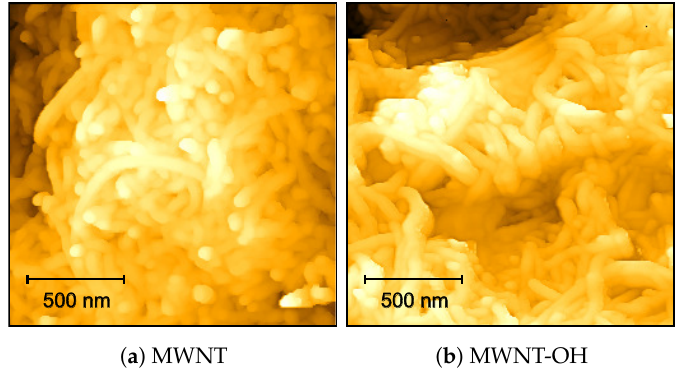
Figure 2. Atomic force microscopy (AFM) images of ( a ) MWNT and ( b ) MWNT-OH at a concentration of 2 mg/mL with scanned dimension of 1.7 µ m × 1.7 µ m. Table 1. The manufacturer-stated and AFM-calculated width of basic and functionalised multi-walled carbon nanotubes (MWNT and MWNT-OH,